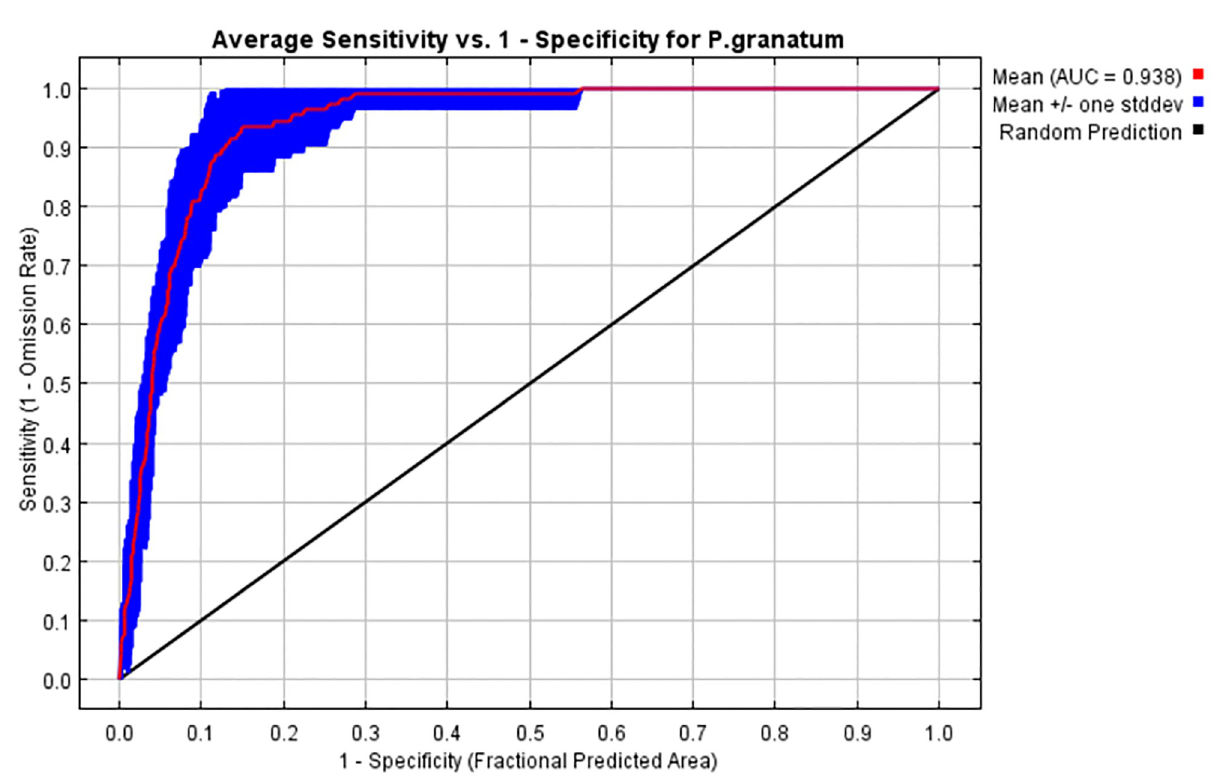
Fig 10. ROC curve of test data to model habitat distribution of pomegranate under the current period.